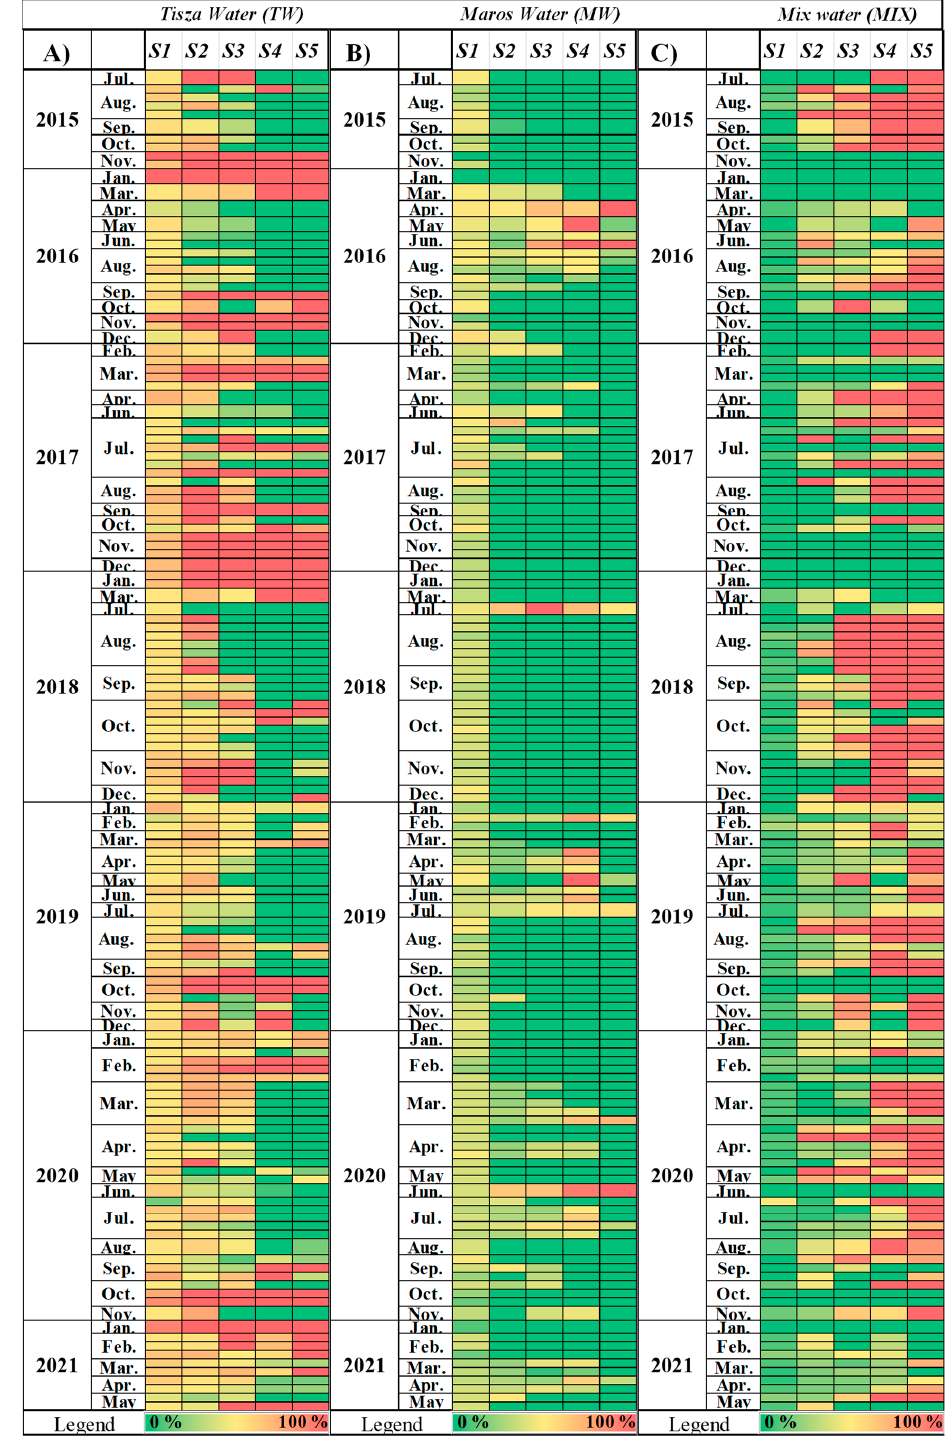
Figure A2. Heat maps of the lateral percentages of ( A ) Tisza water (TW), ( B ) Maros water (MW) and ( C ) their mixture (MIX) at the five cross sections. Each row represents one date, when a Sentinel-2 image was analyzed.